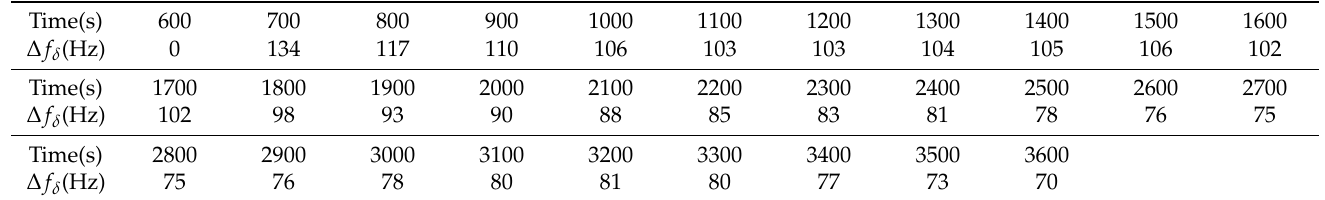
(17) Table 4. Frequency fluctuations test data of low-pass filter output from 600 s to 3600 s when 𝐹 = 90 𝑐𝑁 (the group where the greatest fluctuation occurred, and the red color is the maximum data for this group of tests). Time(s)